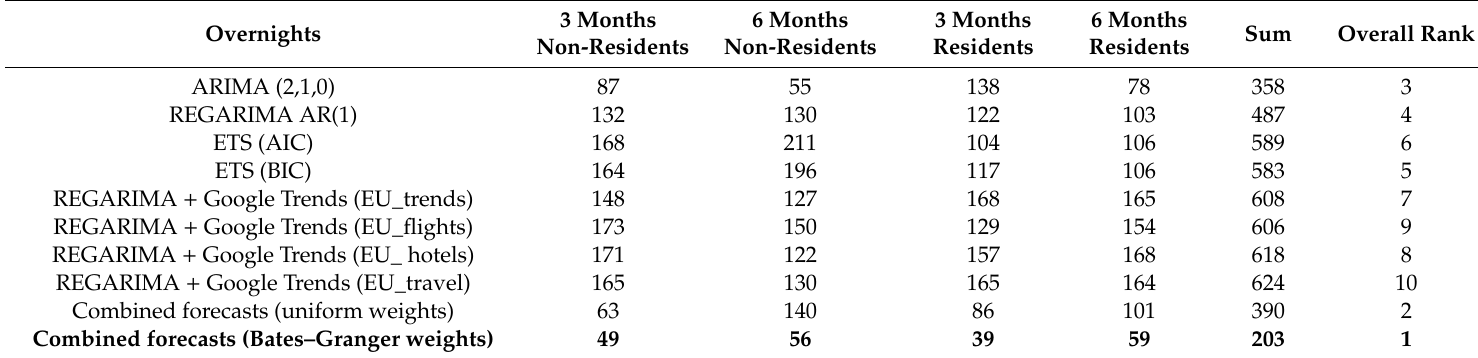
Table 2. Summary ranking of the overall results for overnights forecasts. Source: European Commission (2017) and own calculations. Boldface indicates the single forecasting model(s) / forecast combination technique(s) characterized by the lowest sum of